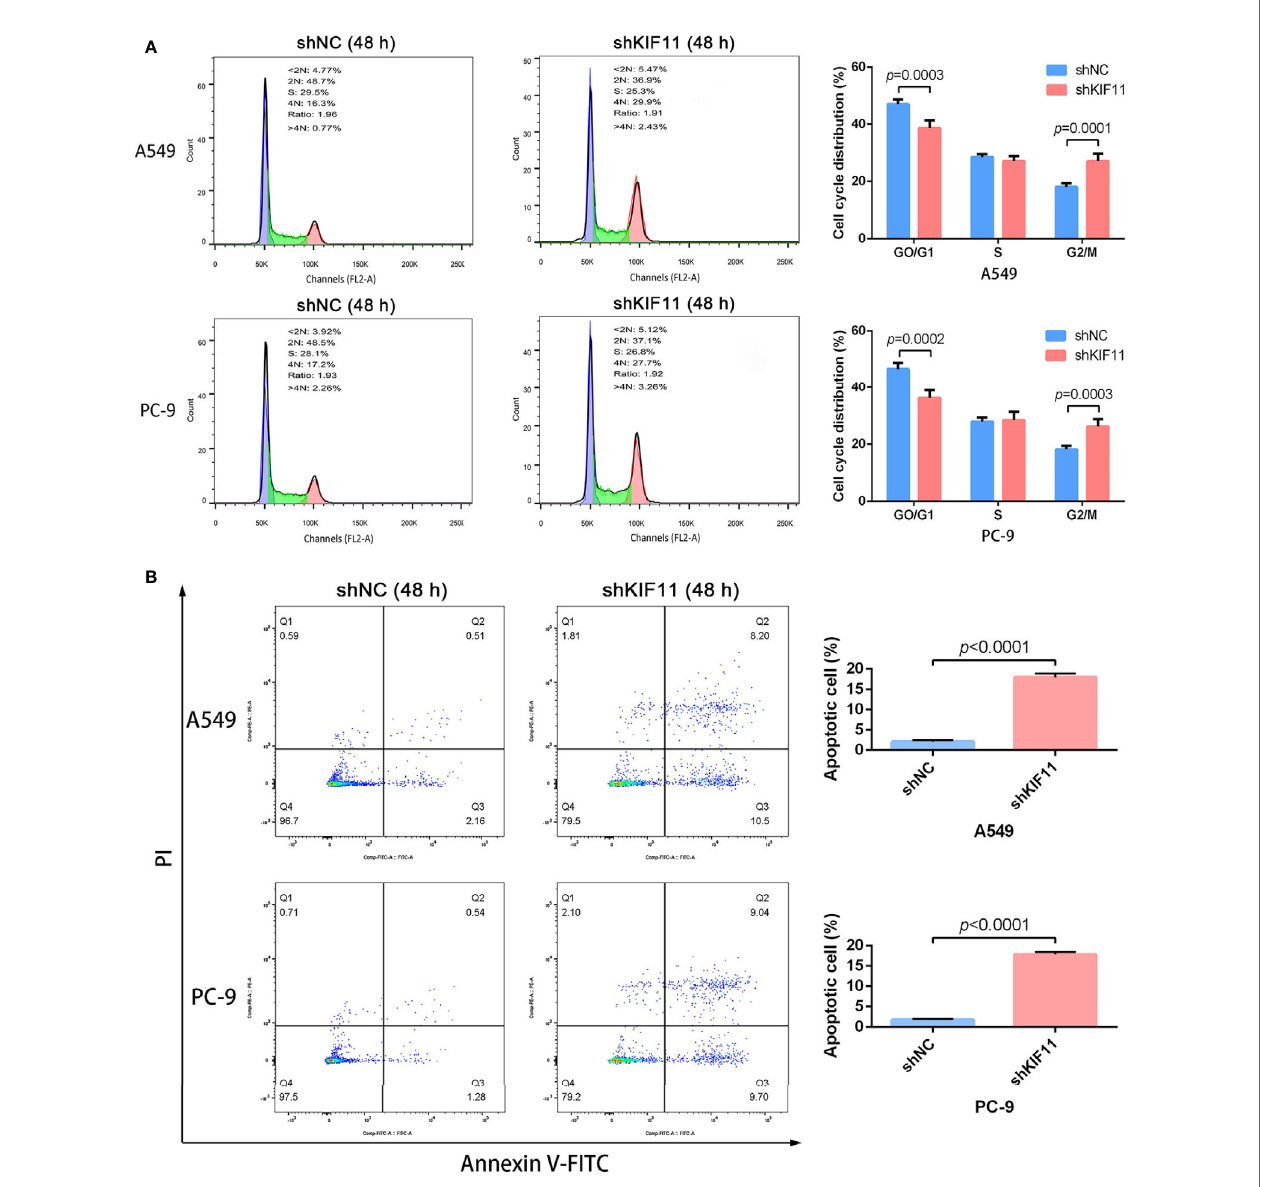
FIGURE 9 | KIF11 knockdown induced the G2/M arrest and apoptosis of LUAD cells. KIF11 knockdown increased the proportions of A549 and PC-9 cells at the G2/M phase (A) . KIF11 knockdown promoted the percentages of apoptotic A549 and PC-9 cells (B)